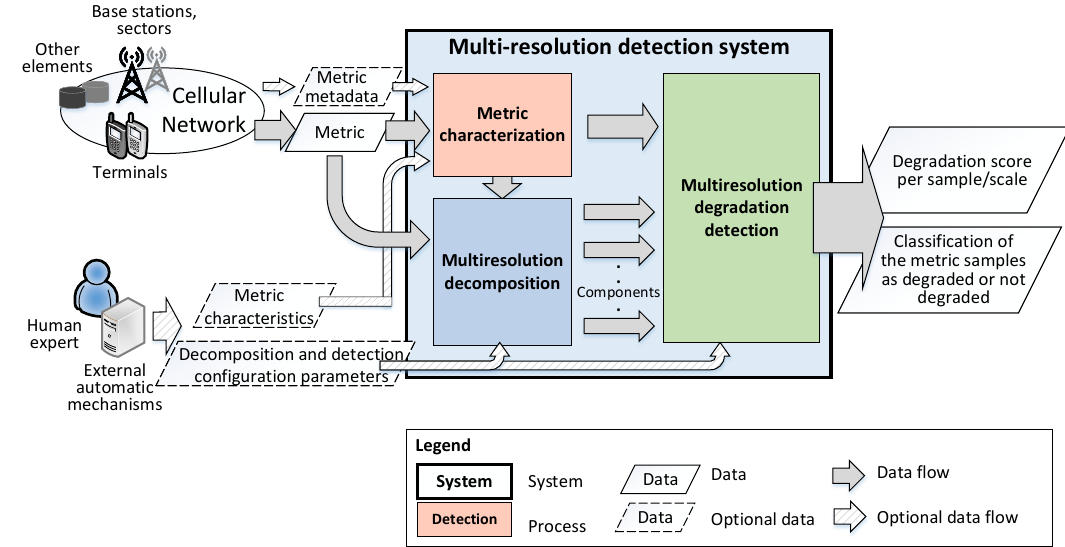
Figure 6. General system scheme in which the network metrics are analyzed for the detection of network